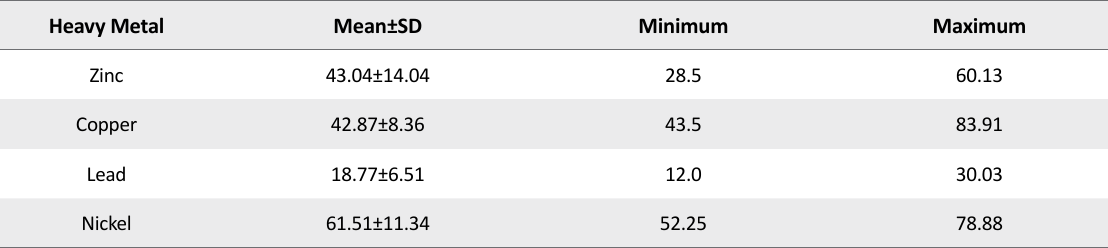
Table 3. Descriptive statistics of heavy metals in the soil of the region